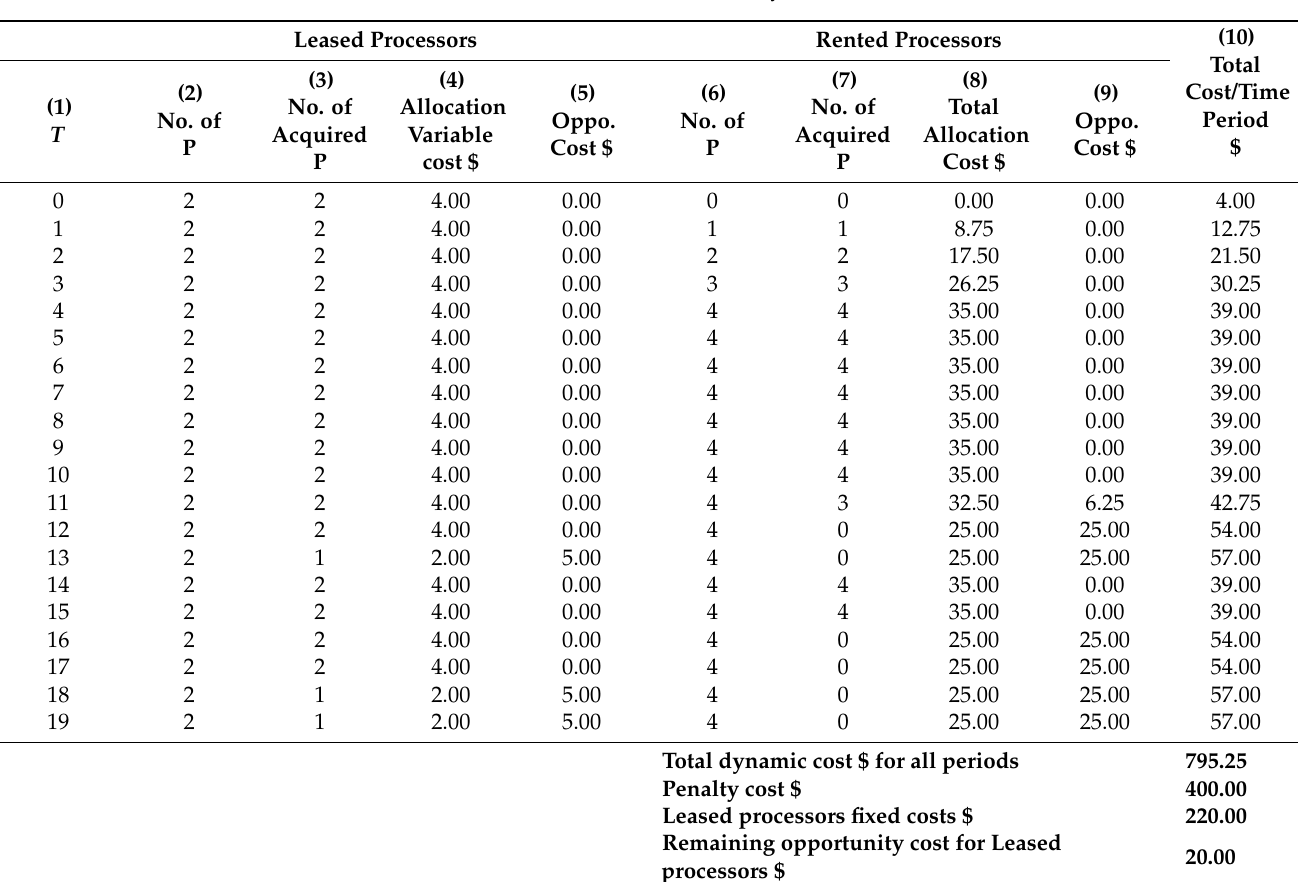
Table 2. DBP cost